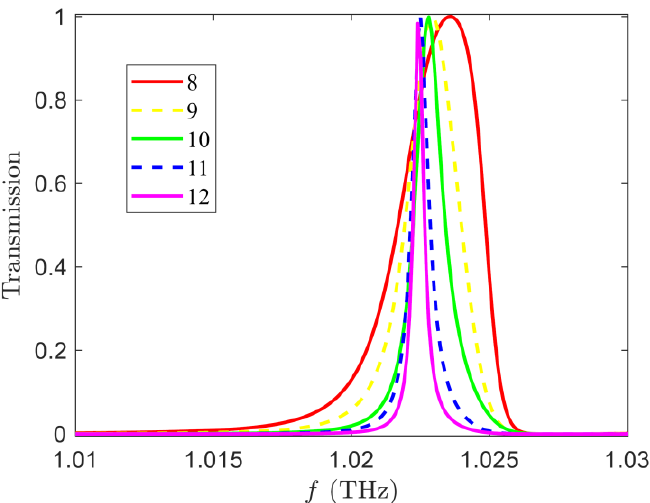
Figure 5. Transmission peaks of the filters with a different number of periods.